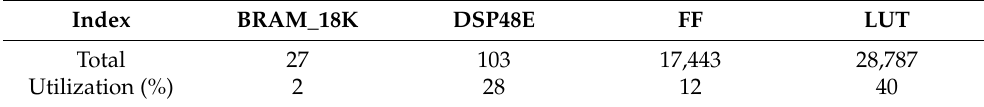
Table 2. Details about IP nuclear resource usage for